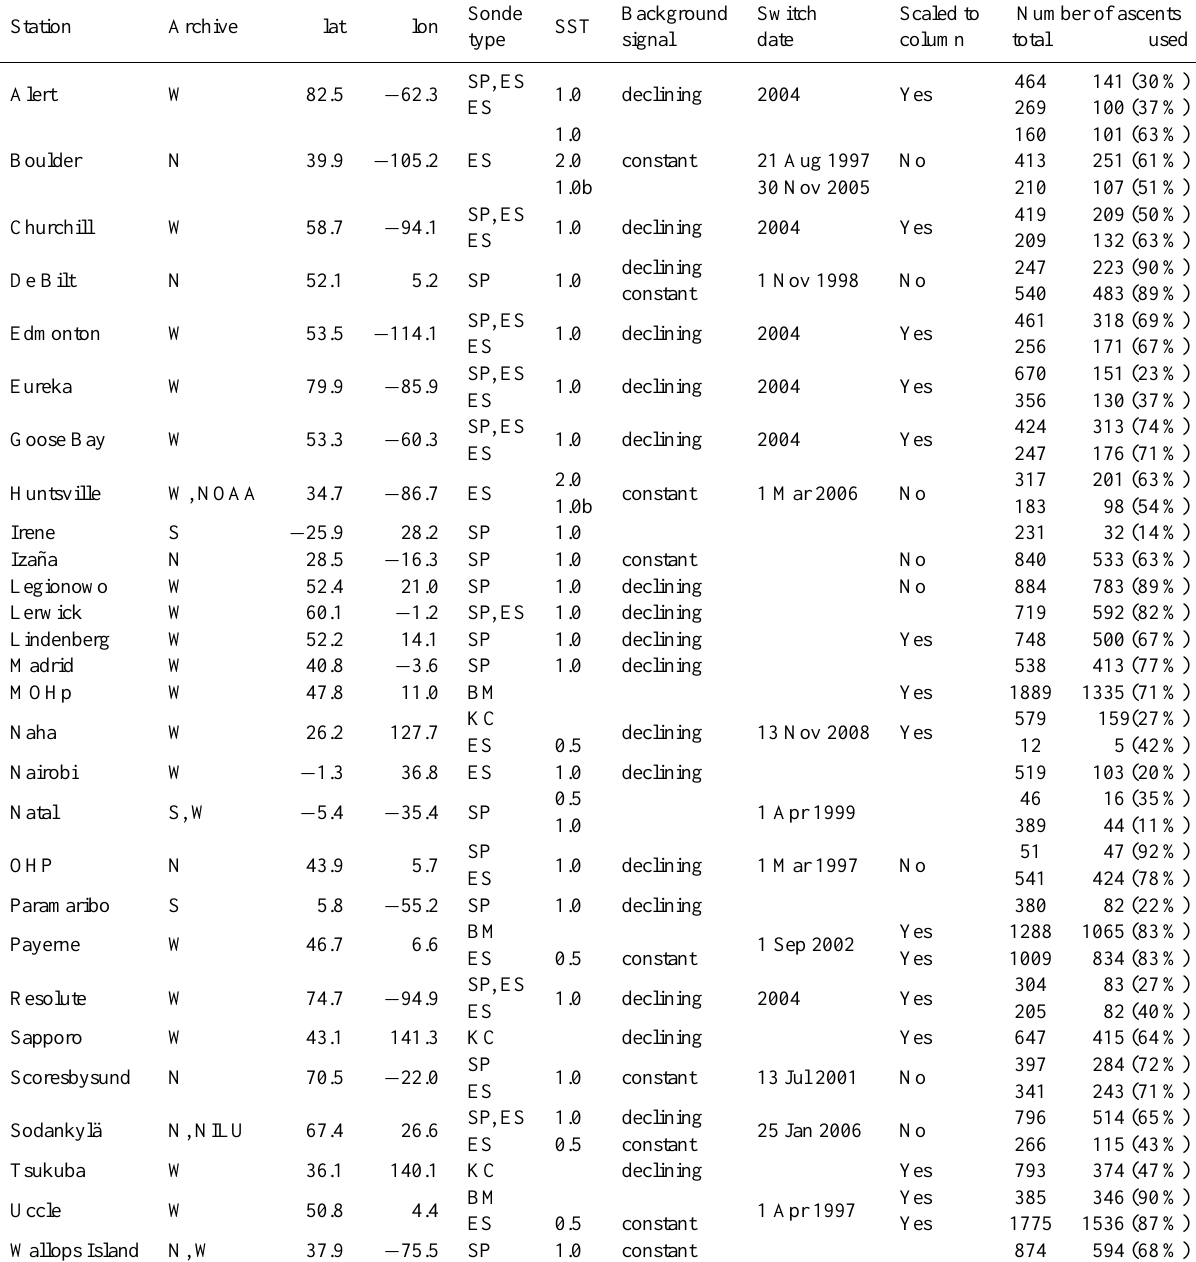
Table 1. Overview of the sonde types used, data processing methods applied for the MOZAIC period (August 1994–March 2009), and soundings available for comparison (see text). Fields are left blank when information is missing or redundant. SST denotes the cathode sensing solution strength of the ECC sondes, whereby SST 1.0 denotes the fully buffered 1.0% KI solution, SST 0.5 the half-buffered